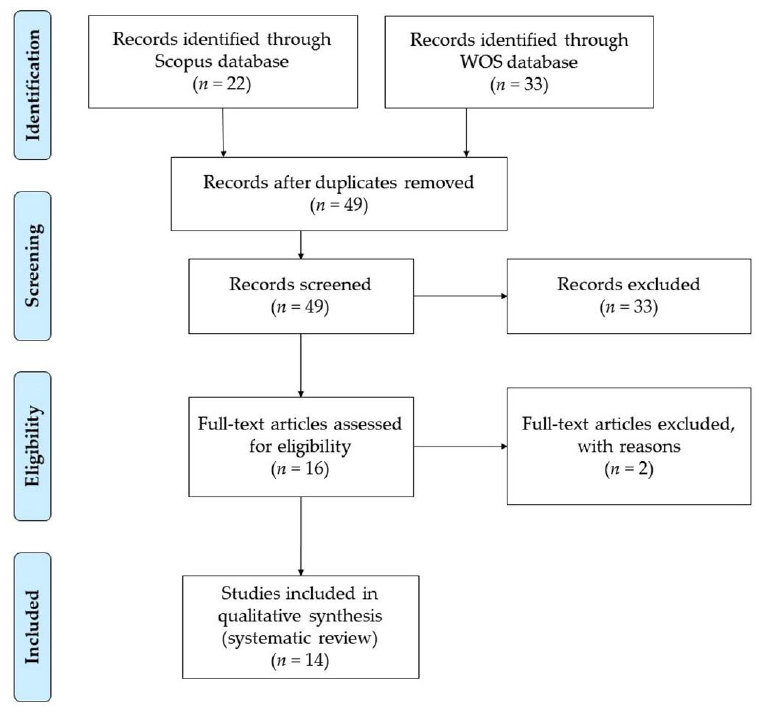
Figure 2. Flow diagram.